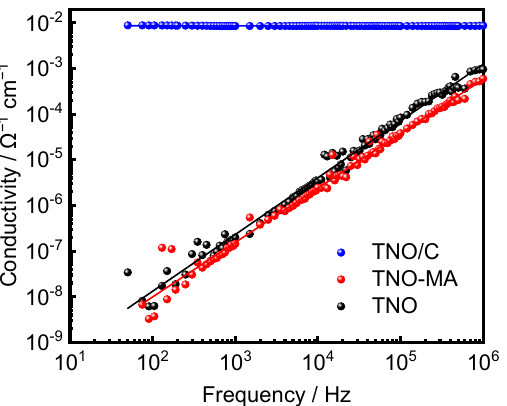
Interestingly, pristine carbon-free TNO mixed only with the binder with a ratio of TNO/PVDF = 95:5 intercalates Li ions during the first discharge at C/10 cycling rate (Figure 9a). The initial discharge capacity was equal to 210.37 mAh g − 1 . Note that TNO showed a clear insulating character with a wide band gap of ~3 eV [22,25]. The conduction band was contributed by d states of Nb and Ti atoms. The valence band was mostly contributed by p states of oxygen atoms [22]. During lithium intercalation, electrons